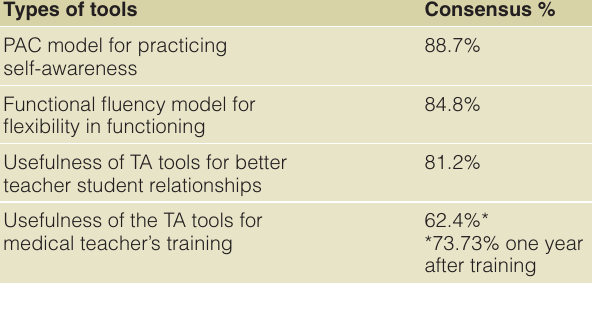
Table 4. Showing consensus of participants on the usefulness of different TA